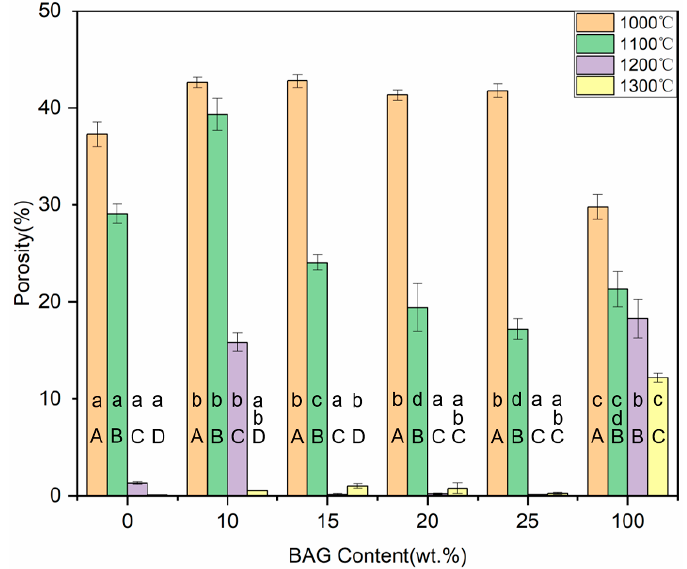
Figure 9. Porosity of ceramics with different sintering temperatures and different BAG contents. a the same lowercase letters indicate that there was no significant difference between different BAG contents at the same sintering temperature ( p = 0.05). A the same uppercase letters indicate that there was no significant difference between different sintering temperatures with the same BAG content ( p = 0.05). The data were significantly drawn from a normally distributed population at the 0.05 level.